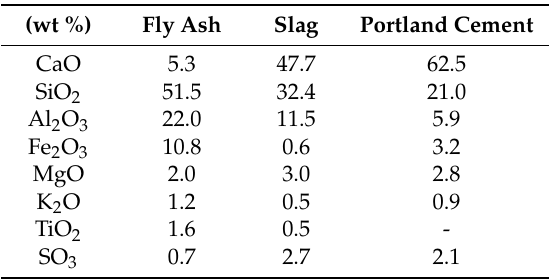
Table 1. Chemical compositions of the raw materials used in this